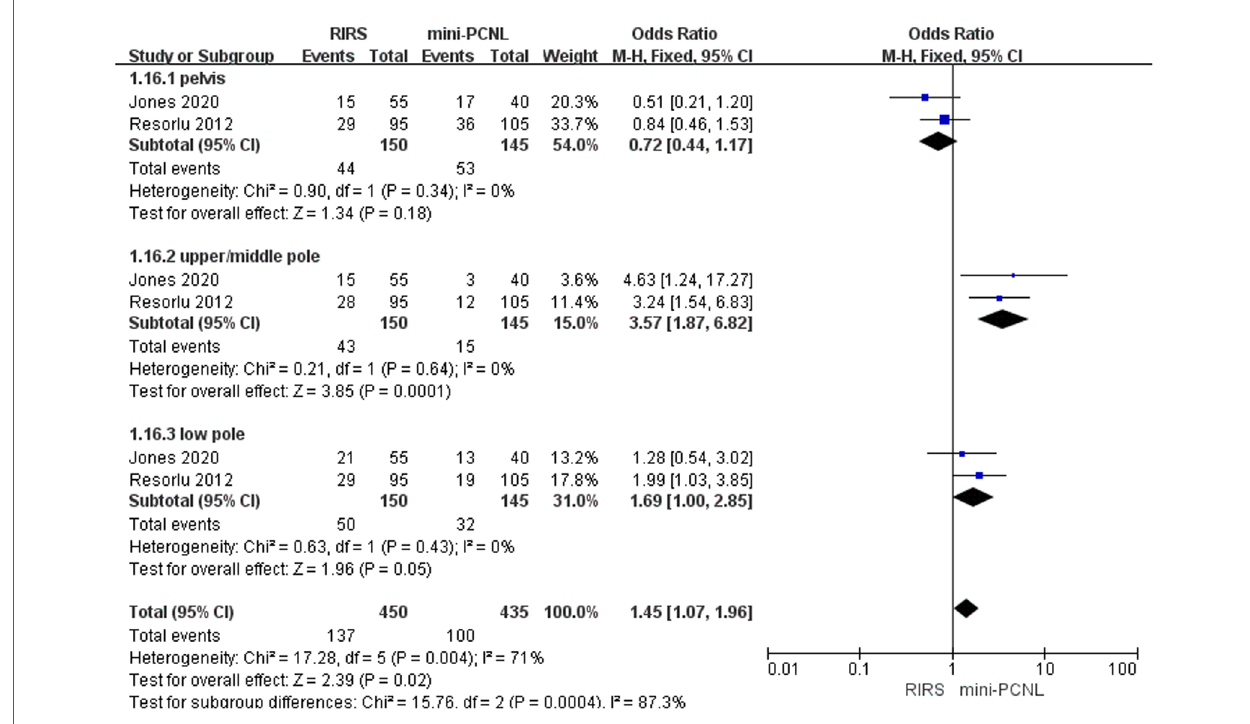
FIGURE 6 Forest plot of stone location between the RIRS group and the mini-PCNL group.